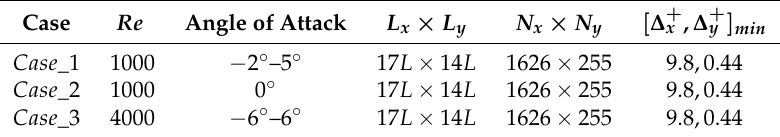
Table 1. Computational parameters. The superscript + means the wall